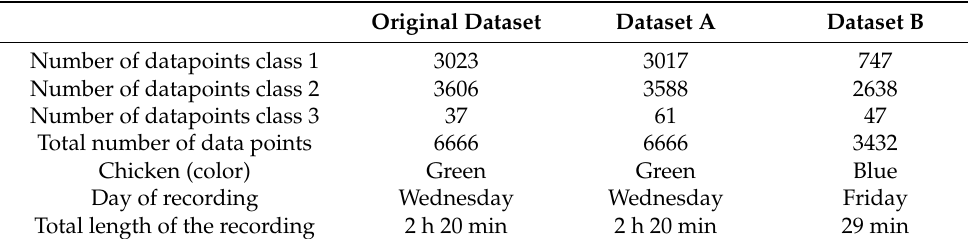
Table 3. Dataset overview with the available number of data points per class and additional information. Two chickens were observed, one wearing a green backpack and one wearing a blue backpack.